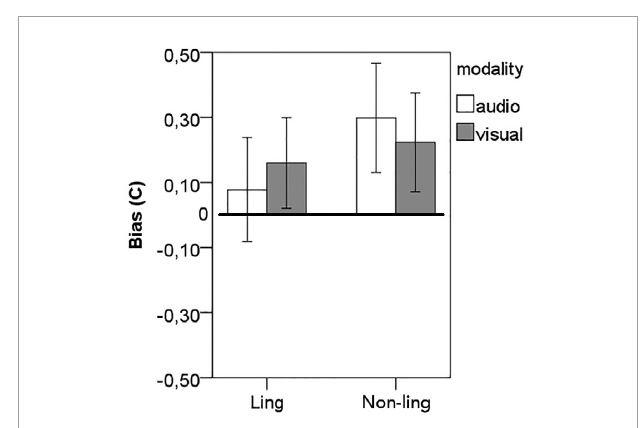
FIGURE4 Response bias. A score of 0 indicates no bias, positive bias reflects a tendency to accept (endorse) test tokens (a tendency to respond “yes”). Error bars stand for